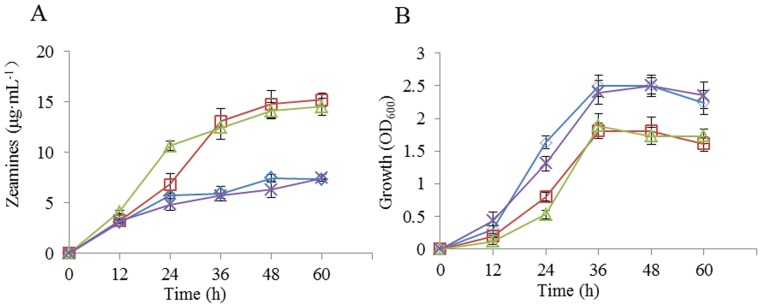
Effect of nitrogen source on zeamines biosynthesis (A) and growth (B) of D. zeae strain EC1.Symbol: (NH4)2SO4 (white diamond), NaNO3 (white square), NH4NO3 (white triangle), NH4Cl (multiplication symbol). Data are the means from four replicates per treatment.